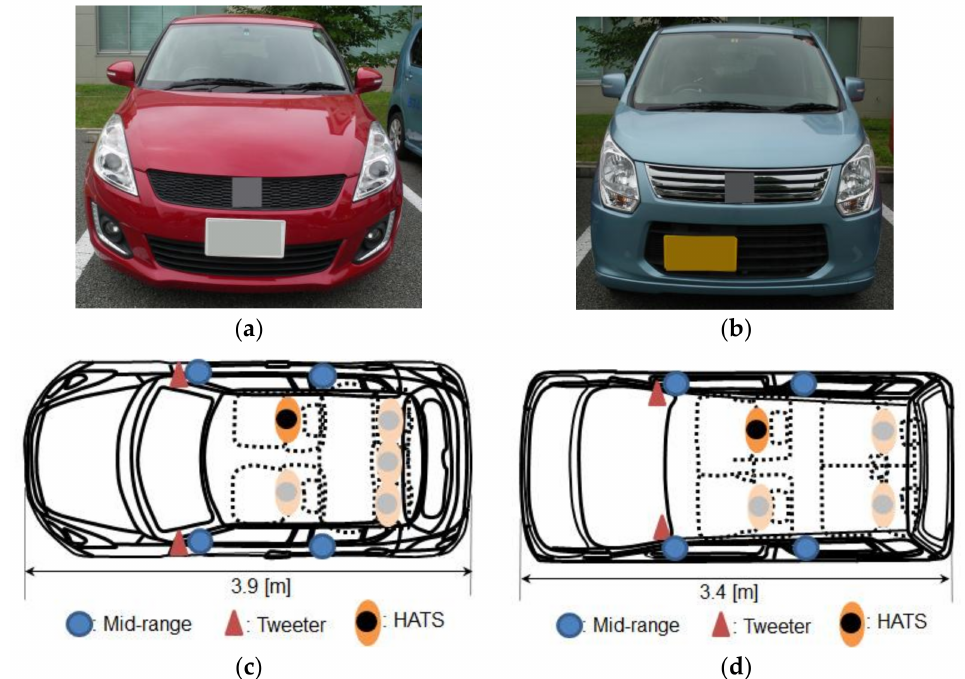
Figure 1. Photographs of ( a ) car A, ( b ) car B and the position of the loudspeakers used in the measurements in ( c ) car A, ( d ) car B. The position of the head and torso simulator (HATS) is shown at the driver’s position.